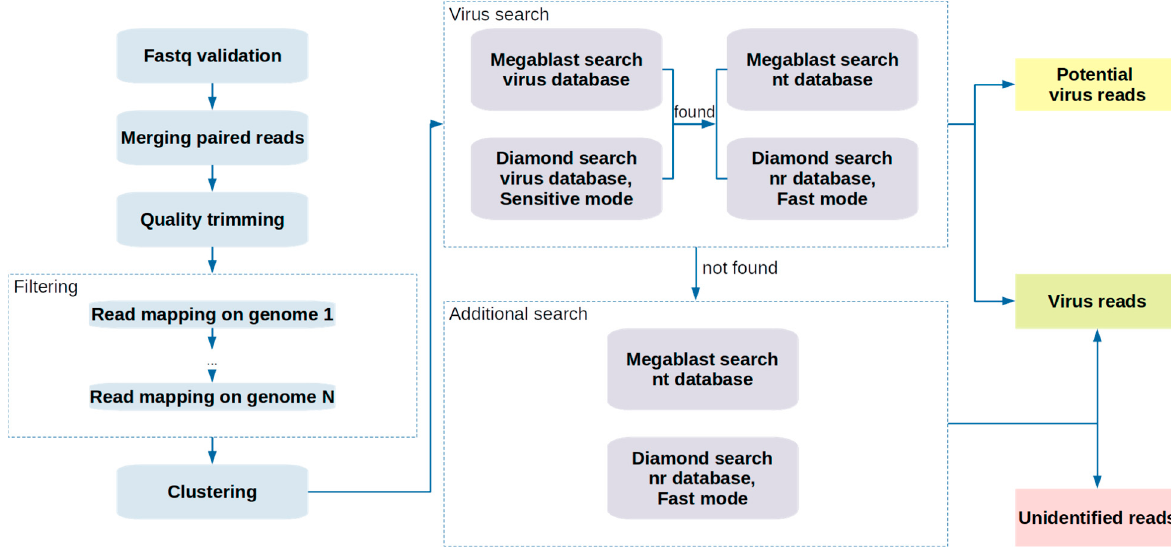
Figure 1. Visual representation of the VirIdAl bioinformatics pipeline for analyzing high-throughput sequencing data for searching DNA fragments of viral pathogens (virus reads), as well as detection of sequences that cannot be identified only on the basis of homology with known genomes (unidentified reads).